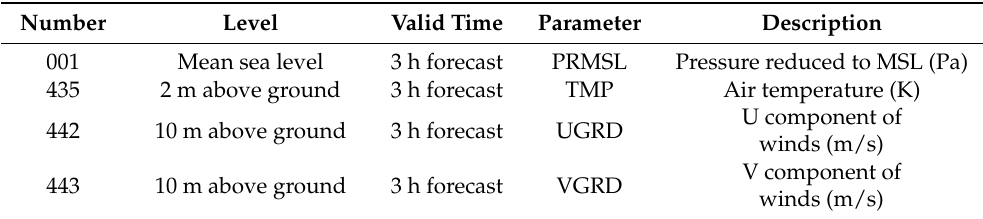
Table 2. GFS parameters. Air pressure (PRMSL), air temperature (TMP), and wind speed and wind di- rection components (UGRD and VGRD, respectively) were used to train the artificial neural